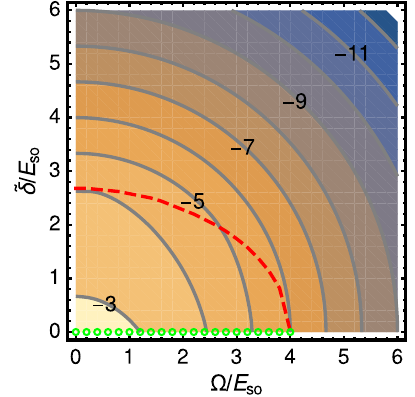
FIG. 5. Lowest relative three-atom scattering threshold. The contours show the energy E aaa atom scattering threshold as functions of Ω =E The thick open circles and thick dashed line indicate the parameter combinations ð of the lowest three-atom scattering threshold is six and four,